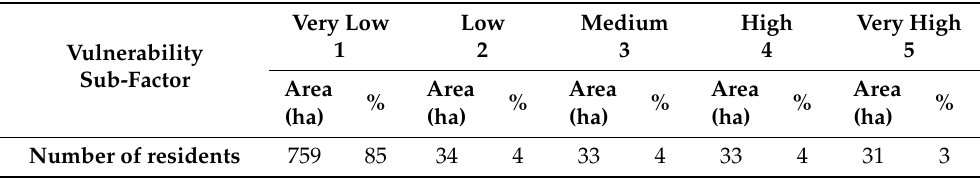
Table 26. Areas and percentages of the study area classified as each class of the number of residents vulnerability